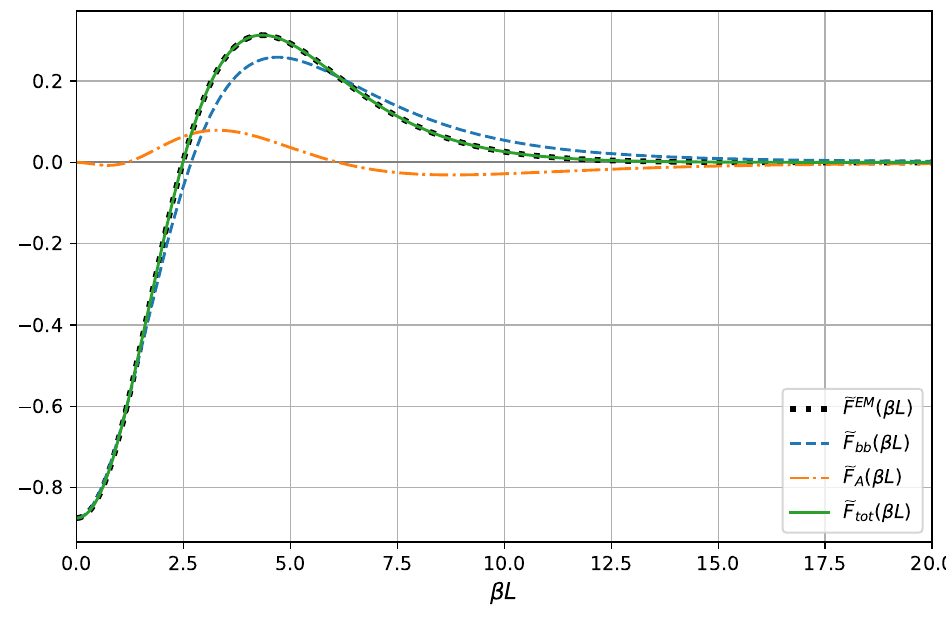
Figure 5 . The relative Casimir force e F tot ( βL ) and its contributions e F A ( βL ) and e F case that one plate is PEC and the other is PMC. The relative Casimir force in a homogeneous chiral medium e F EM ( βL ) is also shown for